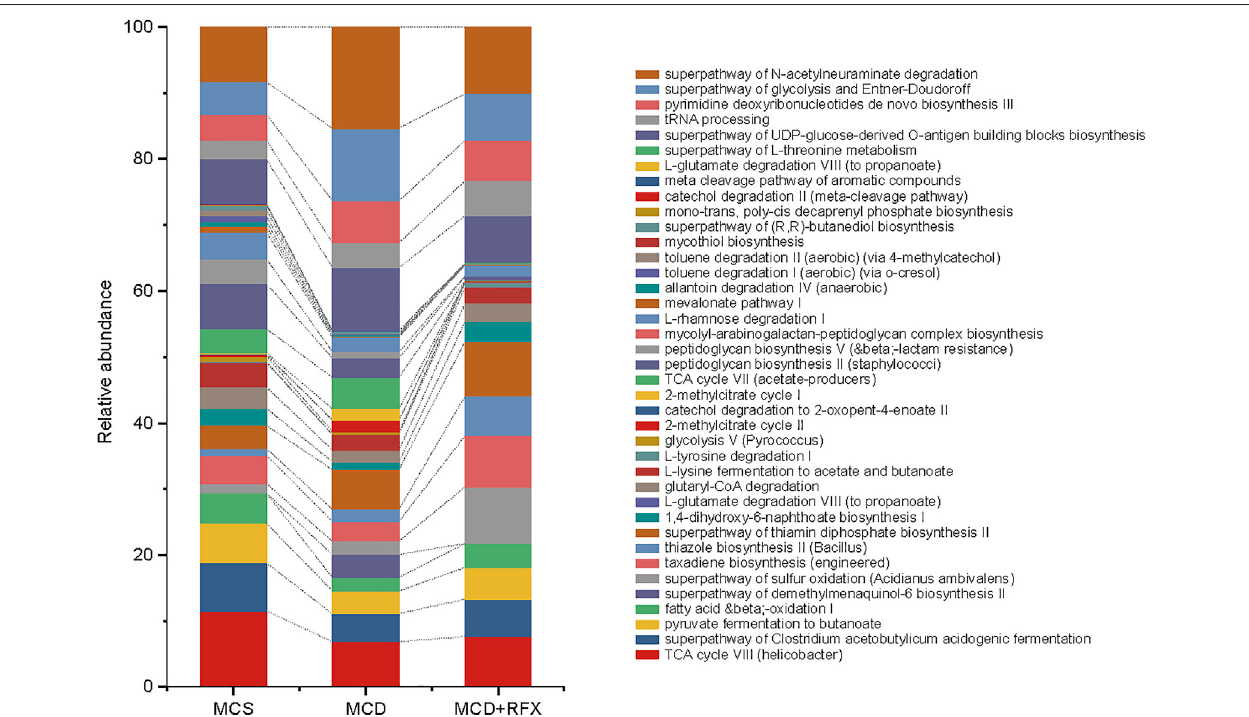
FIGURE 4 | Functional pathways of the gut microbiome were altered by MCD diet and rifaximin treatment. KEGG pathways that were enriched or depleted in different treatment groups were identi fi ed by PICRUSt analysis and selected using linear discriminant analysis through pairwise comparison between multiple groups (log(LDA) > 2 and p < 0.05). Stacked bars display the relative abundance of different KEGG biological